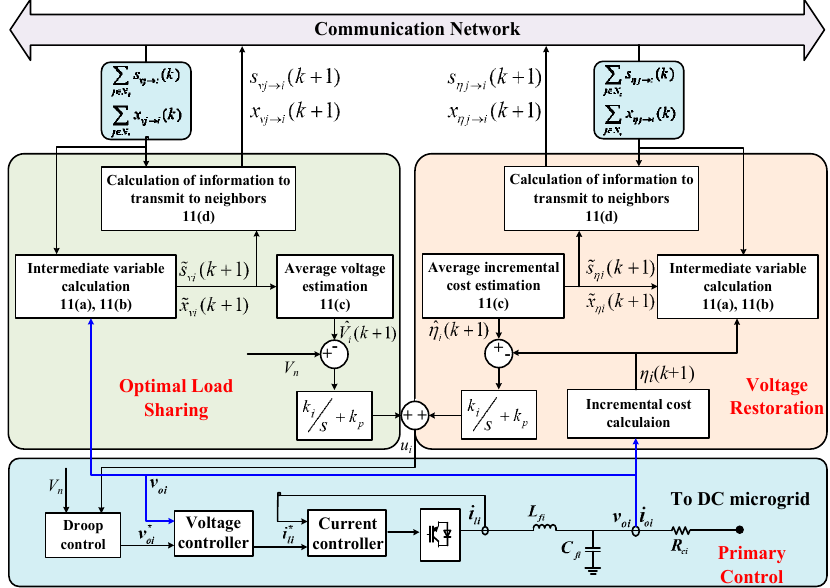
Figure 3. Implementation structure of distributed control adopting fast convergence